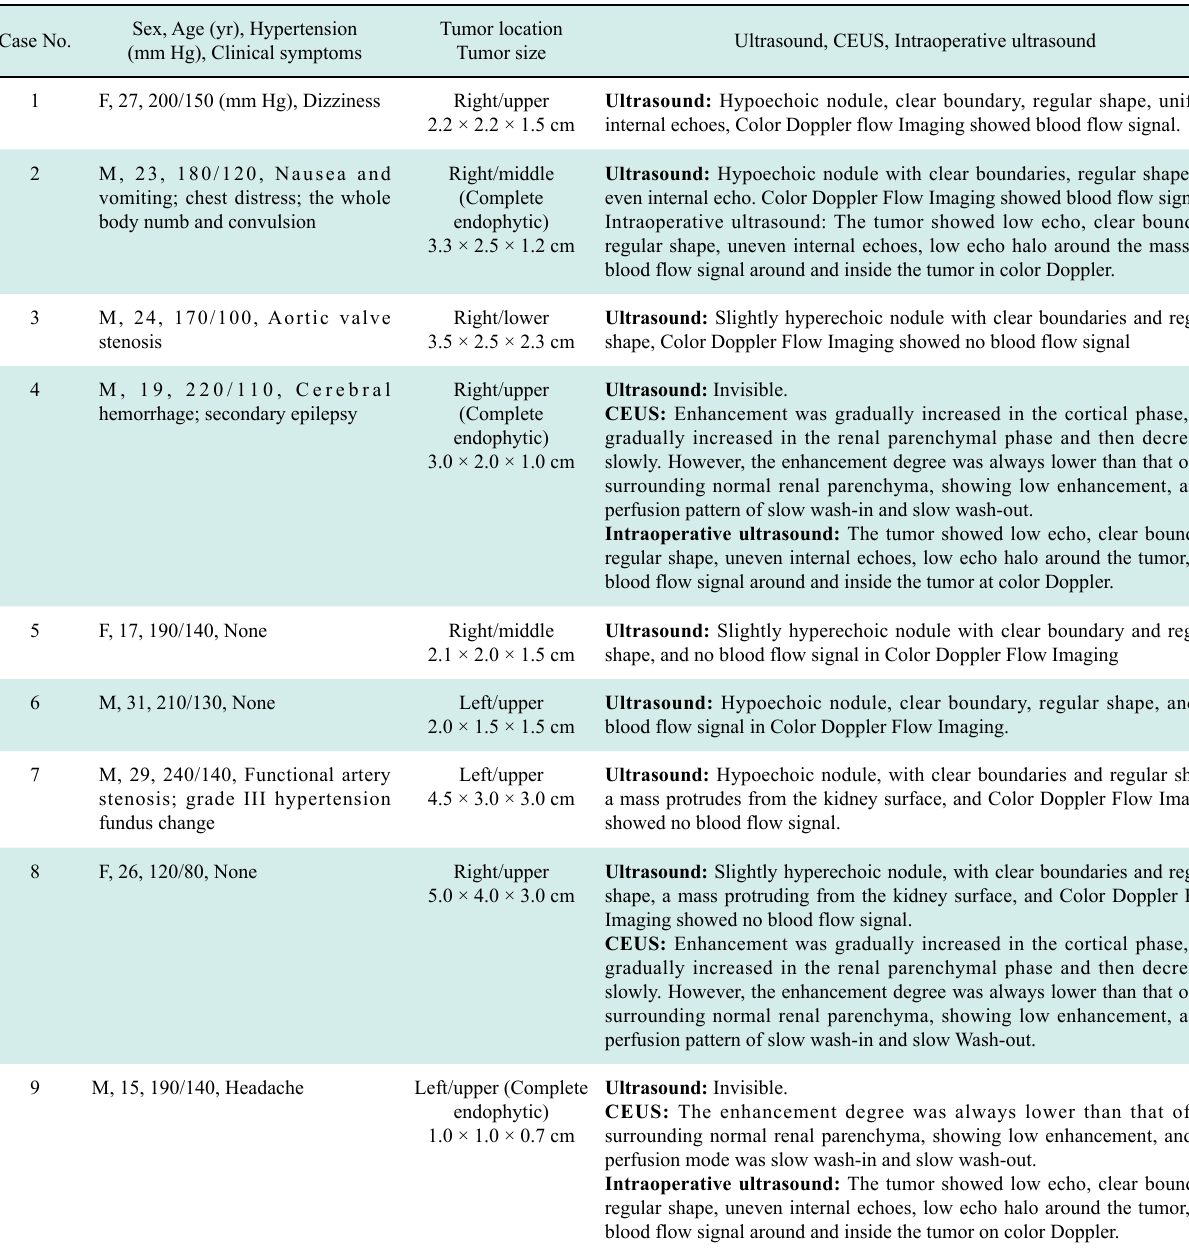
Table 1 Clinical data and ultrasound features in patients with